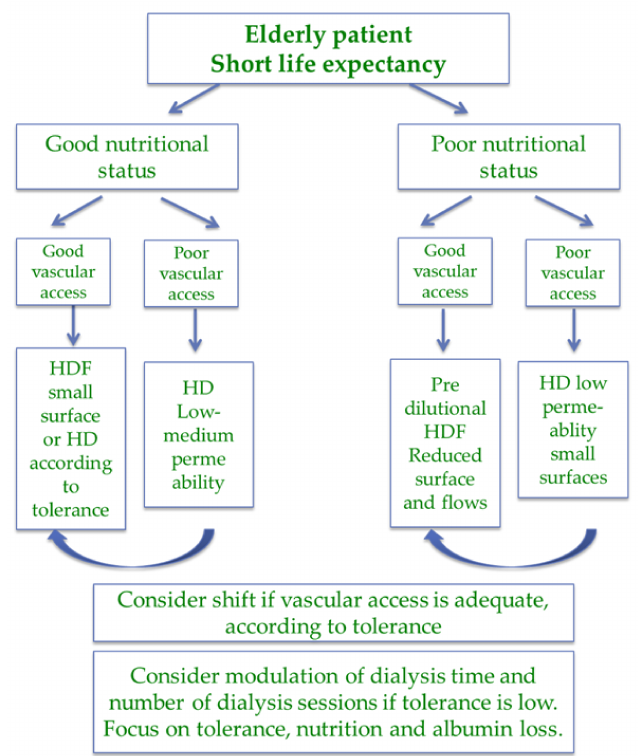
Figure 4. Choice of dialysis (hemodialysis (HD) or hemodiafiltration (HDF)) in the elderly fragile